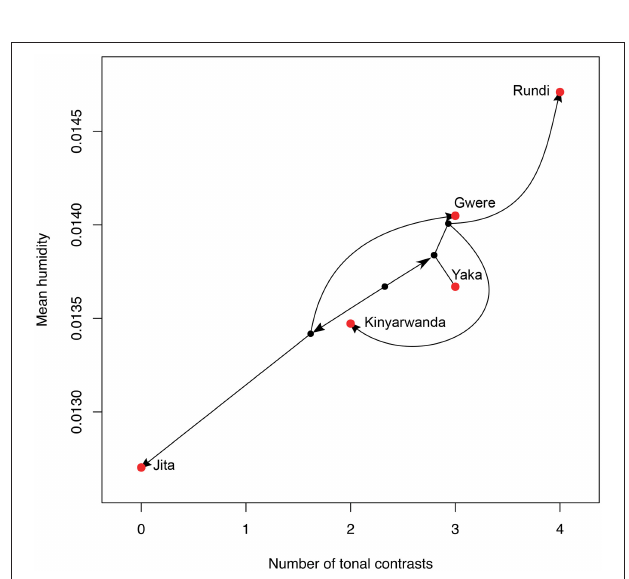
FIGURE 8 | Phylomorpho space plot of Northeast Savannah Bantu languages. Red dots are the actual attested languages, and these are joined with lines to black dots representing their ancestors reflecting the consensus phylogenetic tree from Currie et al. (2013), where the position of ancestor points regarding both number of tonal contrasts and mean humidity are calculated via continuous ancestral state reconstruction. Some of the branches of the tree are altered for clarity, line lengths are not meaningful.